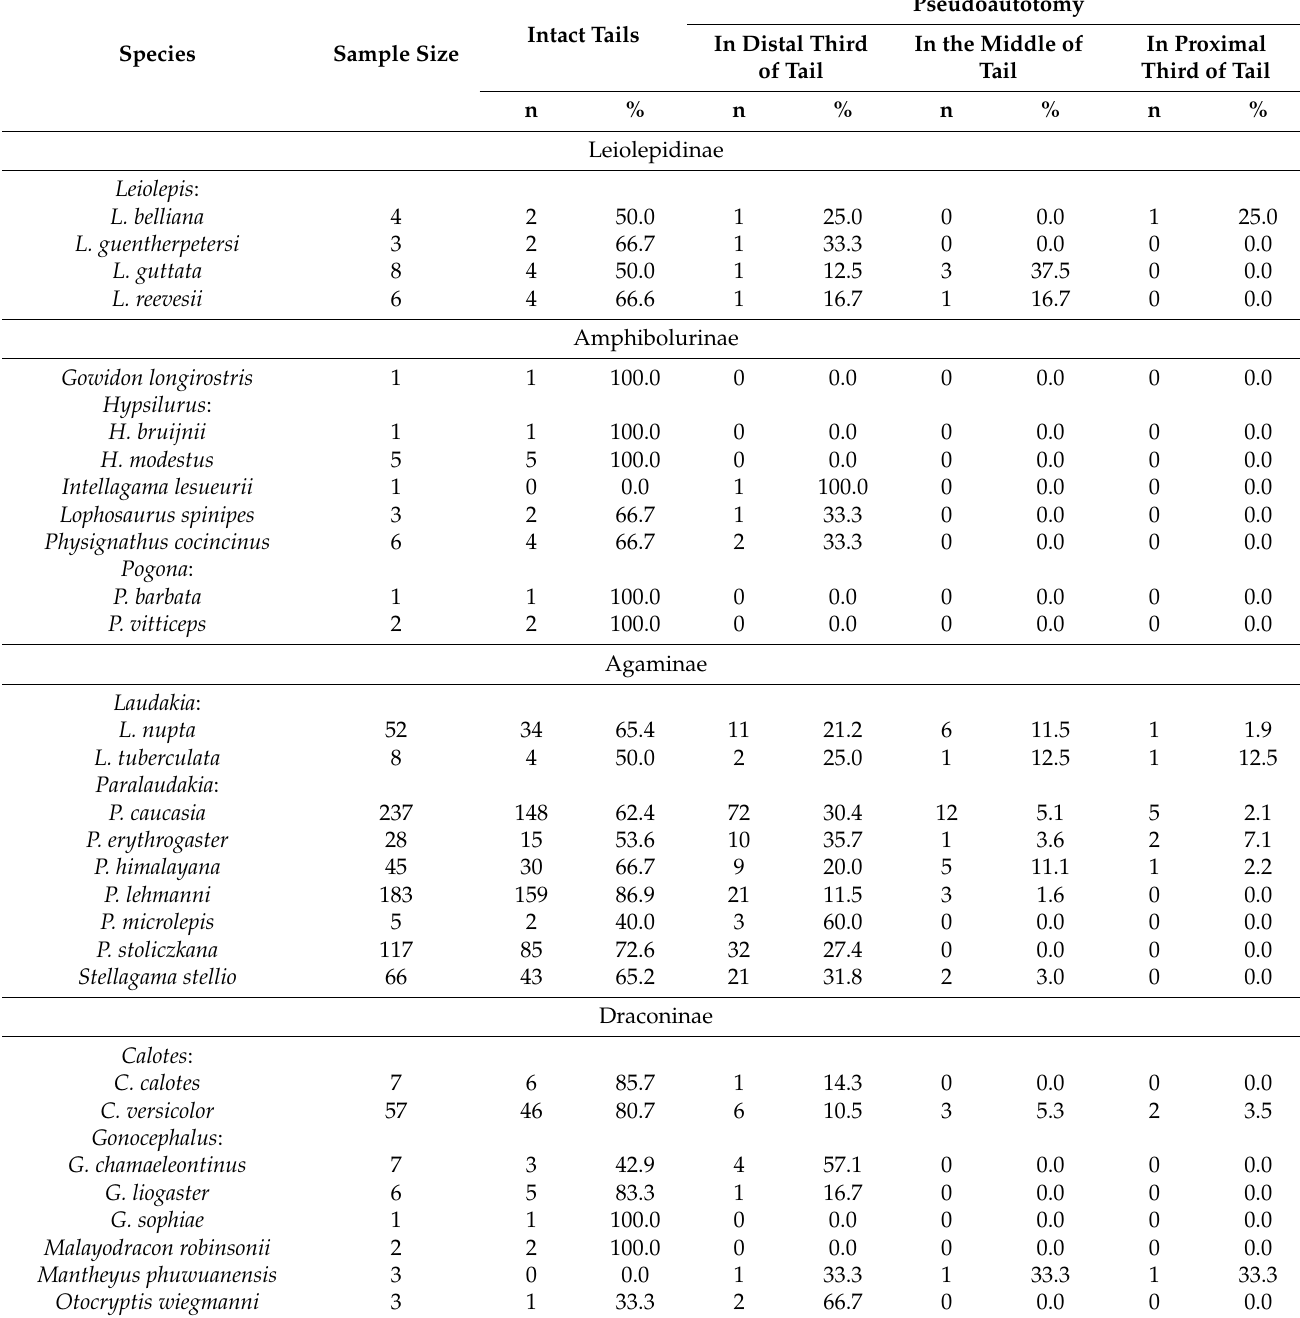
Table 2. Incidence of pseudoautotomy of studied agamid